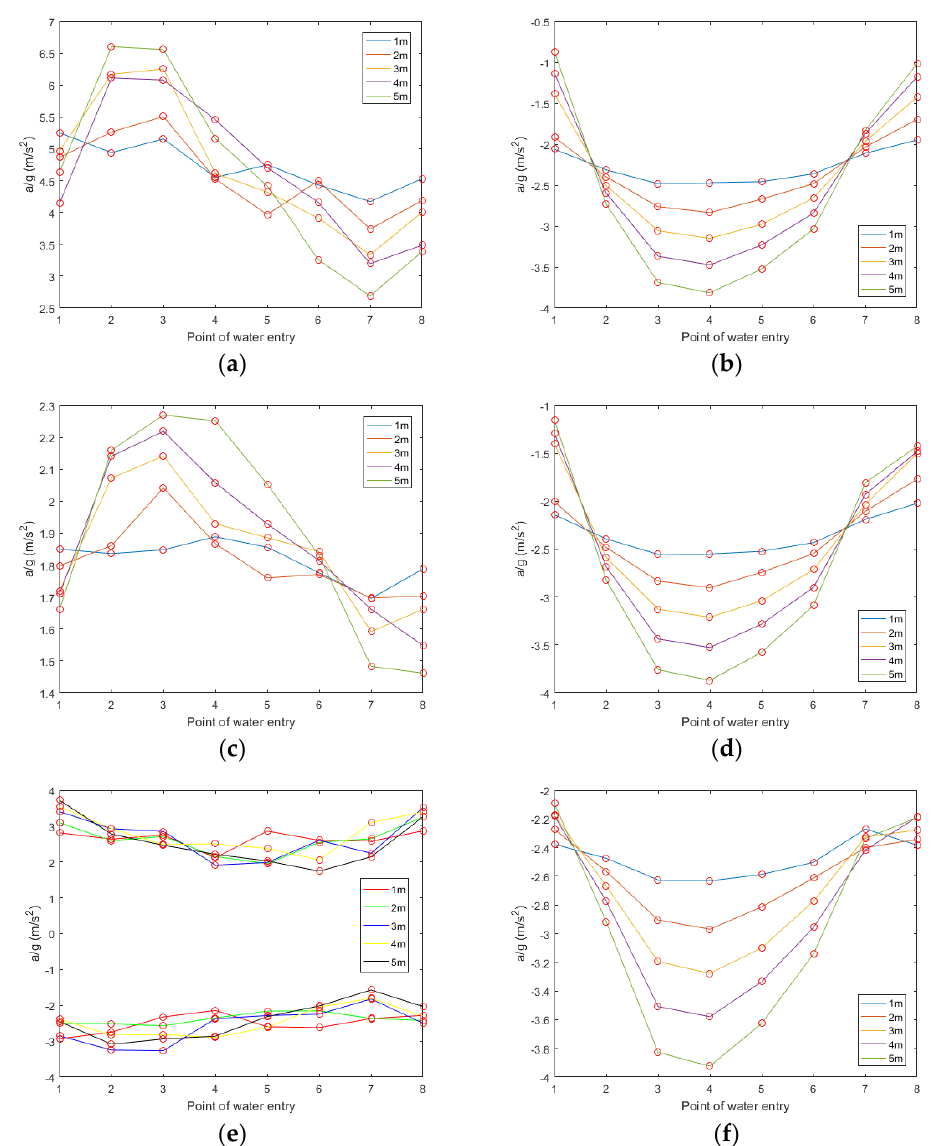
Figure 18. The maximum acceleration of the bow, midship, and stern in the coordinate system of the